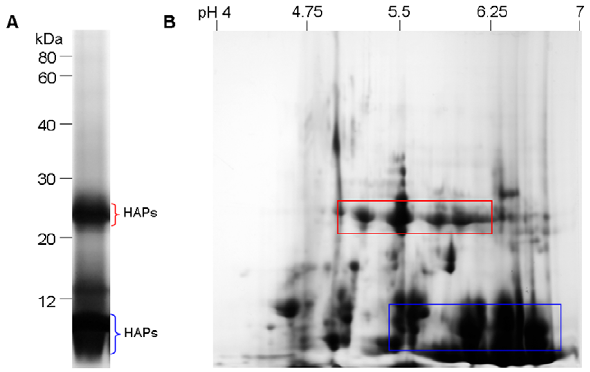
Figure 1. Protein profiles of total proteins of Pinelliaternata tubers separated by SDS-PAGE and 2-DE. Total protein was extracted from acetone tissue powder of P. ternata tubers with SDS- containing buffer and purified by phenol extraction. Protein loads were 30 m g ( A ) and 400 m g ( B ), respectively. Gels were stained with CBB R. HAPs in tuber extract were indicated. Rectangles: indicating the mask effect of HAPS on other protein spots ( B ).